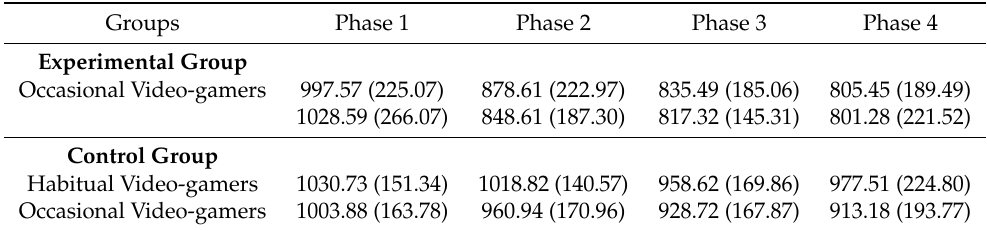
Table A5. Means (and standard deviations) of the RTs in the Working Memory Test N-Back Re- search